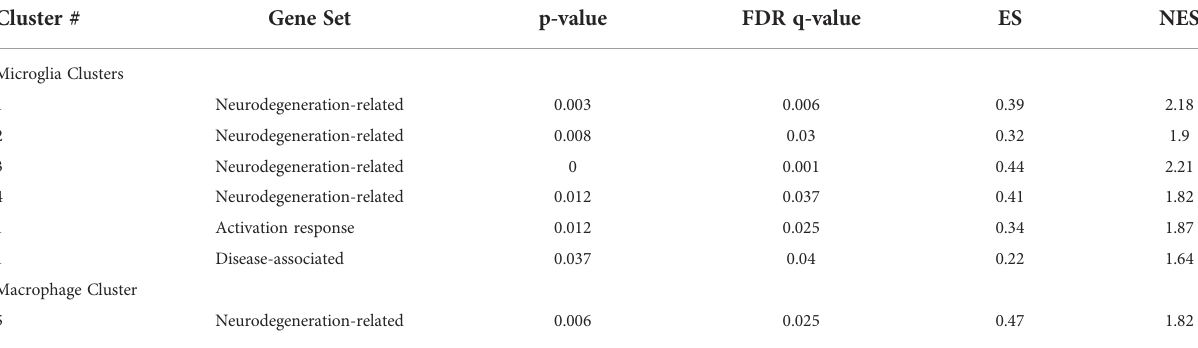
TABLE 1 Gene set enrichment analysis. The enrichment score (ES) is the degree to which a set is overrepresented comparing the morphine with the saline group. Cluster # Gene Set Microglia